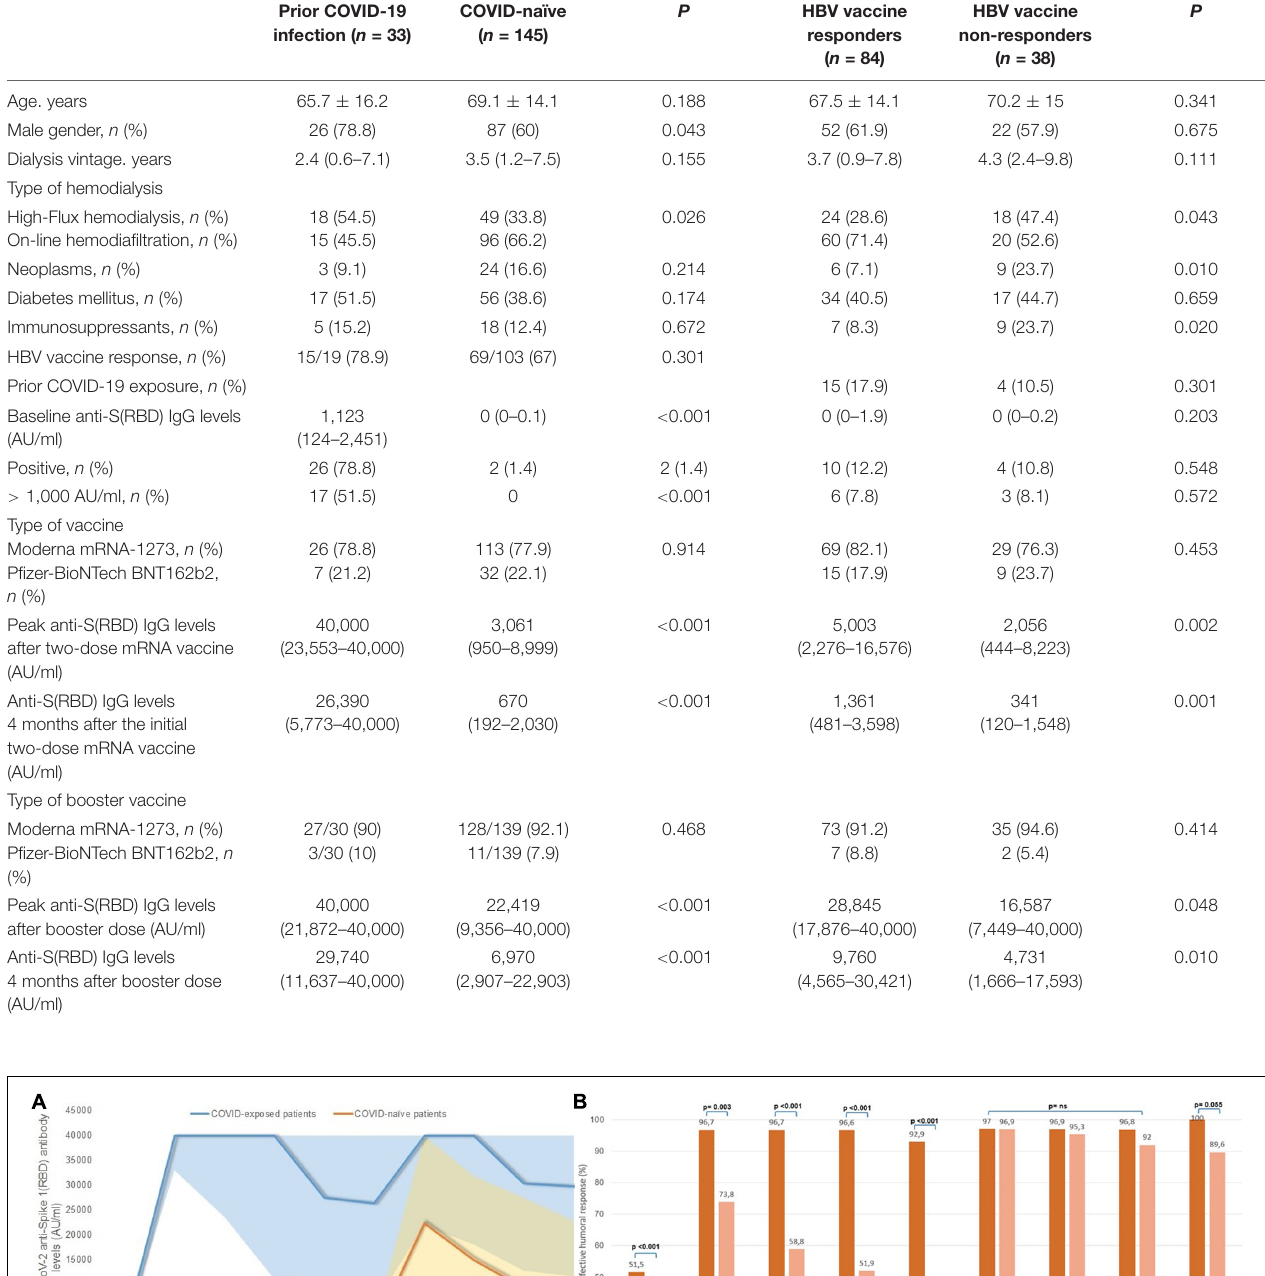
TABLE 2 | Baseline characteristics and anti-S(RBD) levels follow-up stratified according to previous SARS-CoV-2 exposure: and HBV vaccine response status. Prior COVID-19 infection ( n = 33)